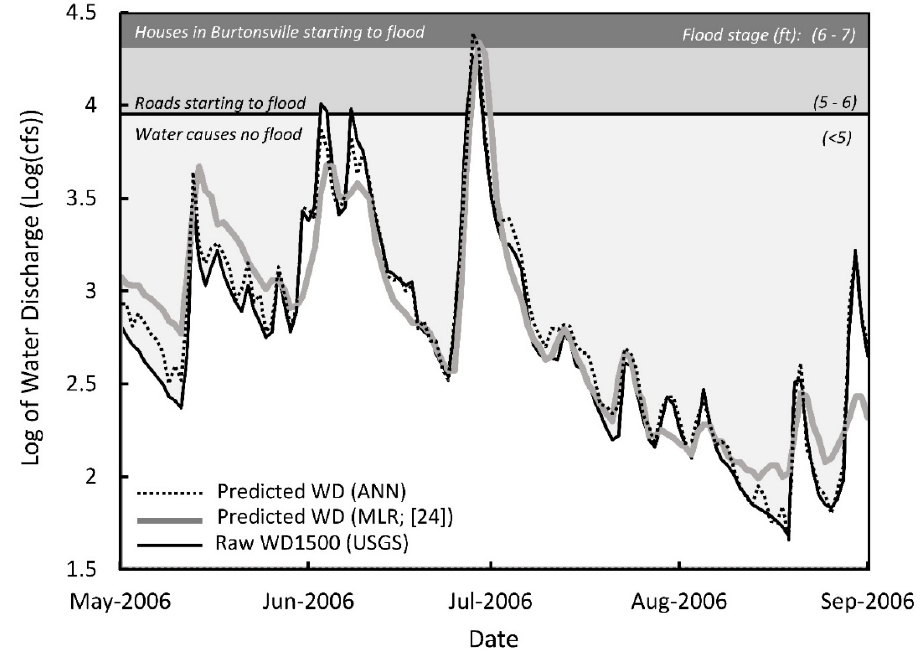
Figure 8. The predicted MLR and ANN values plotted against the raw values of the water discharge time series for the station WD1500. Significant peaks reflect the impact of the Mid-Atlantic United States flood of 2006 (25 June to 5 July 2006) in Schoharie Creek. The water discharge gage station is located in the Schoharie watershed.